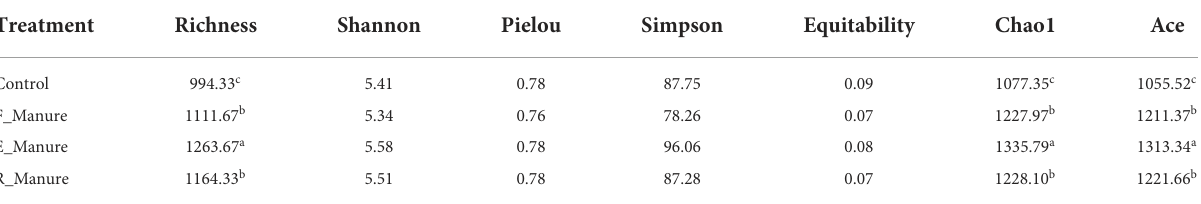
TABLE 1 Alpha diversity for bacterial communities in the four treatments of